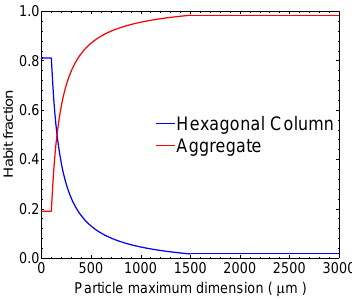
Figure 3. Ice crystal habit fraction as a function of particle maxi- mum dimension for the two-habit